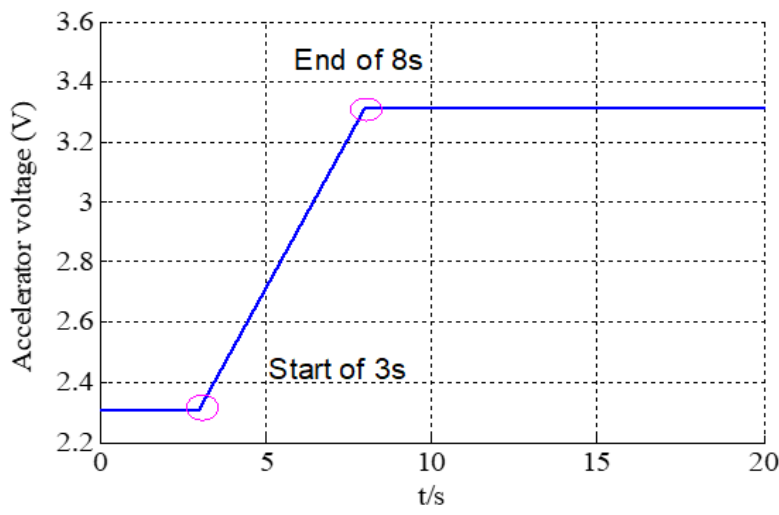
Figure 3. Accelerator voltage changes with time.